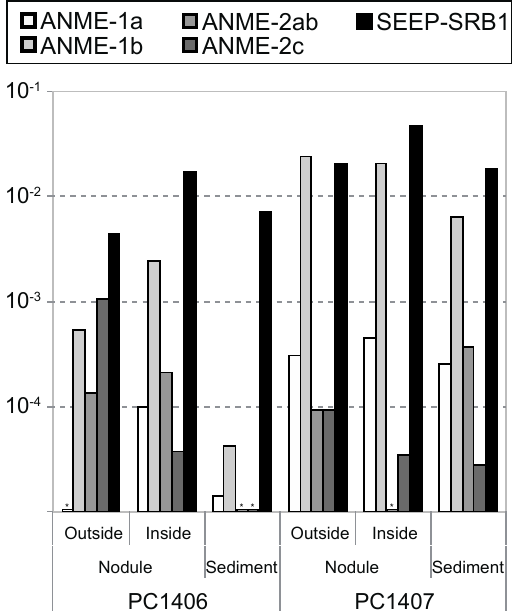
Figure 6. The relative taxa abundance of ANME-1a, -1b, -2ab, -2c, and SEEP-SRB1 members.